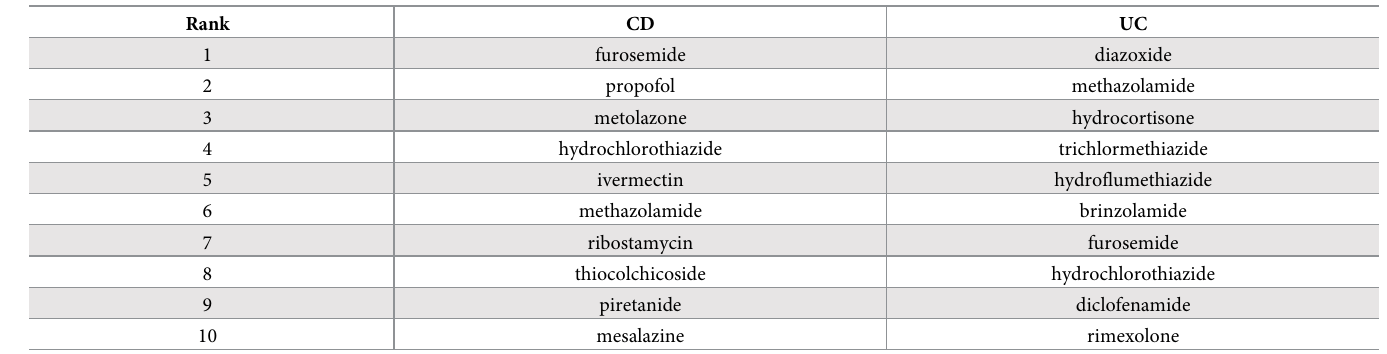
Table 3. Overall average drug rankings for CD and UC human colonic samples.